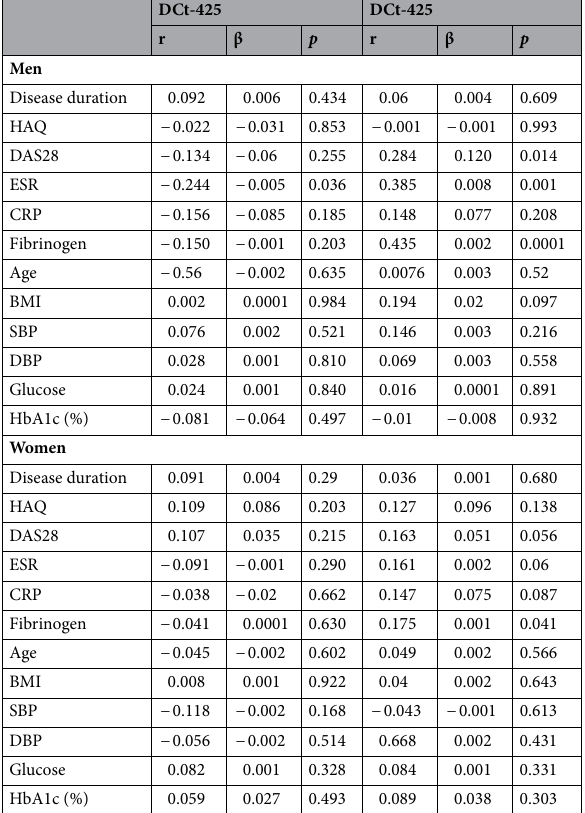
Table 4. Disease-related variables and variables characteristics of the population studied associated with the expression levels of miR-425-5p and miR-451 stratified by sex. SBP = systolic blood pressure, DBP = diastolic blood pressure, HAQ = health assessment questionnaire index, ESR = erythrocyte sedimentation rate, CRP = C-reactive protein, DAS28 = disease activity score, BMI = Body mass index, HbA1c =